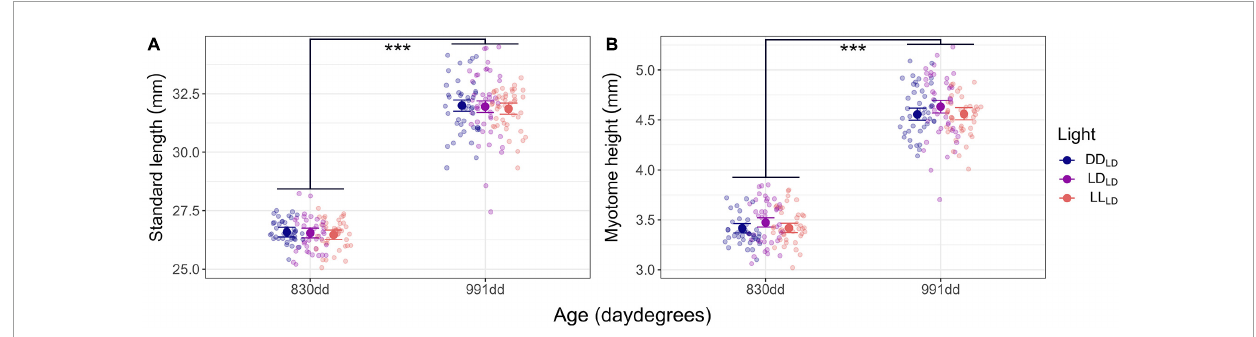
FIGURE2 Model predicted values and raw data of growth in first feeding Atlantic salmon at 830 dd and 991 dd. (A) Standard length (mm). (B) Myotome height (mm). The larger dots and lines indicate model-predicted means and 95% confidence intervals, respectively, for each age. Transparent dots represent individual raw data points. Per light condition group at 830 dd n = 41 for DD LD and LD LD , and n = 42 for LL LD . Per light condition group at 991 dd n = 44 for DD LD and LL LD , and n = 42 for LD LD . Asterisks show the significant level (*** indicates p < 0.001).